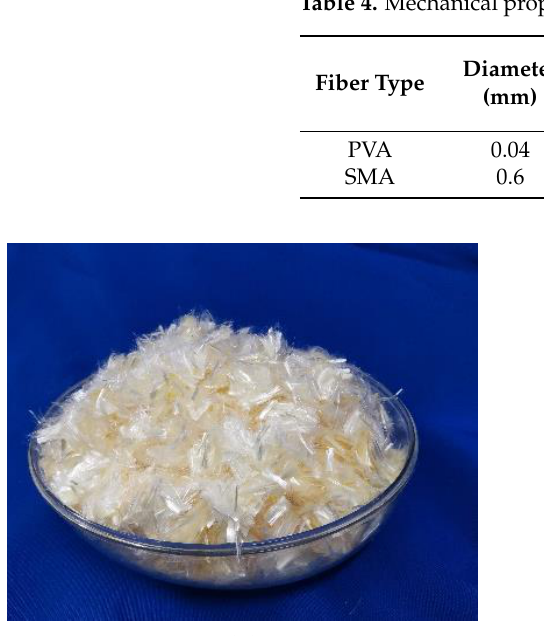
Figure 4. Specimens being soaked. 3.2. Chlorine Salt Solution Transmission Amount Detection After immersion and drying in each dry-wet corrosion period, the corroded speci- mens (SMA-ECC and MC) were weighed using an electronic scale with a weighing accu- racy of 0.1 g. The erosion of the solution during the soaking stage and the evaporation of the solution during the drying stage were recorded for various times of the dry-wet cycle. In order to ensure the measurement accuracy, the corroded specimens in soaking stage were wiped dry before weighing. There was a close correlation between the transmission amount of chloride salt solu- tion and the porosity of the specimen. For example, the capillary flowing in soaking stage during the dry-wet corrosion cycle process can accelerate the corrosion of chloride ions on the specimen. For the measurement method of porosity of the specimen, please refer to “GB/T 24586 -2009 Determination of apparent density, true density and porosity of iron ore”. The calculation formula (1) is as follows: (